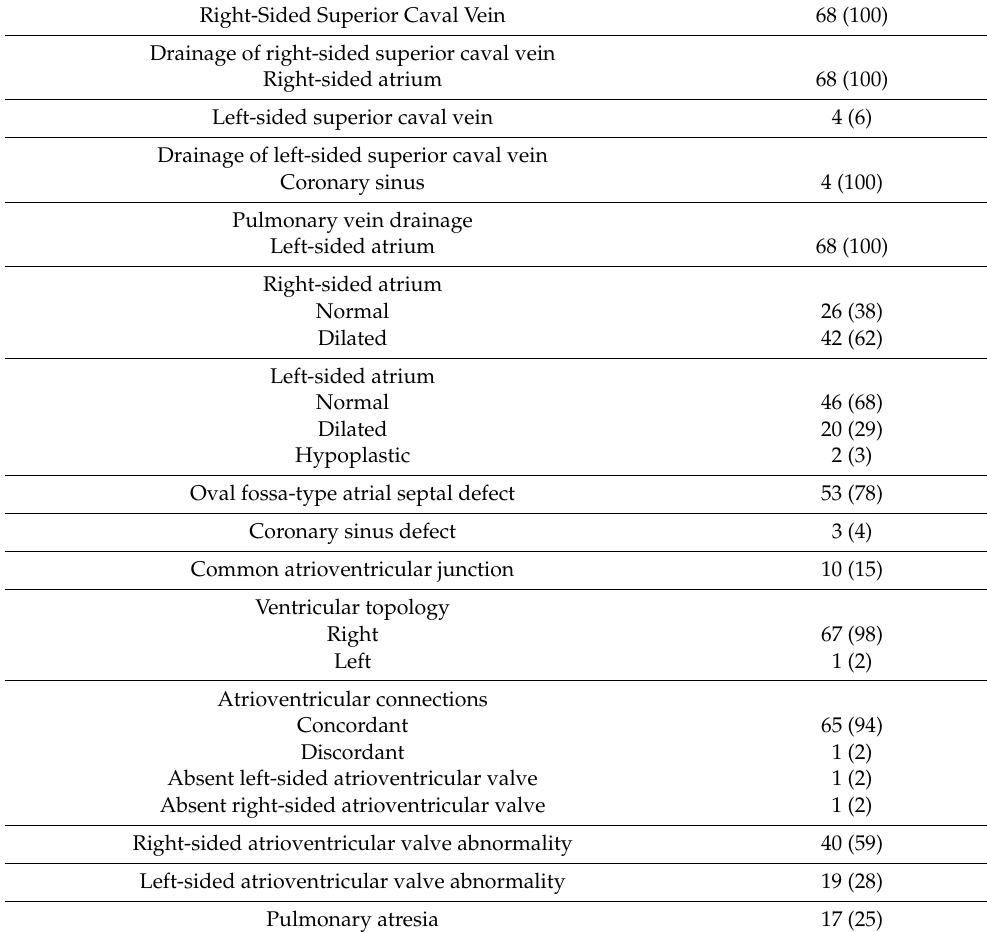
Table 1. Characteristics of the specimens noted to have vestibular atrial septal